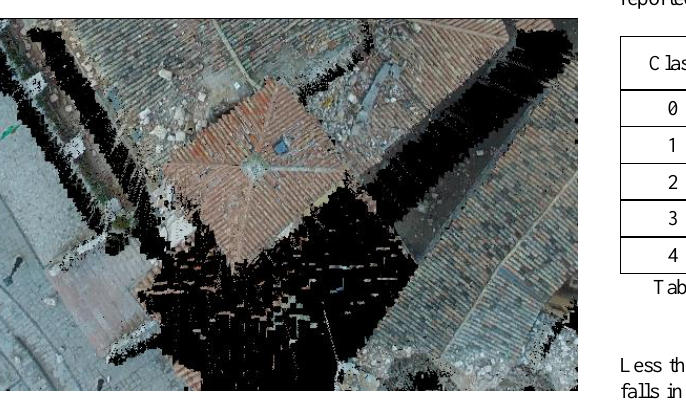
Figure 9. Orthophoto by MAGO.